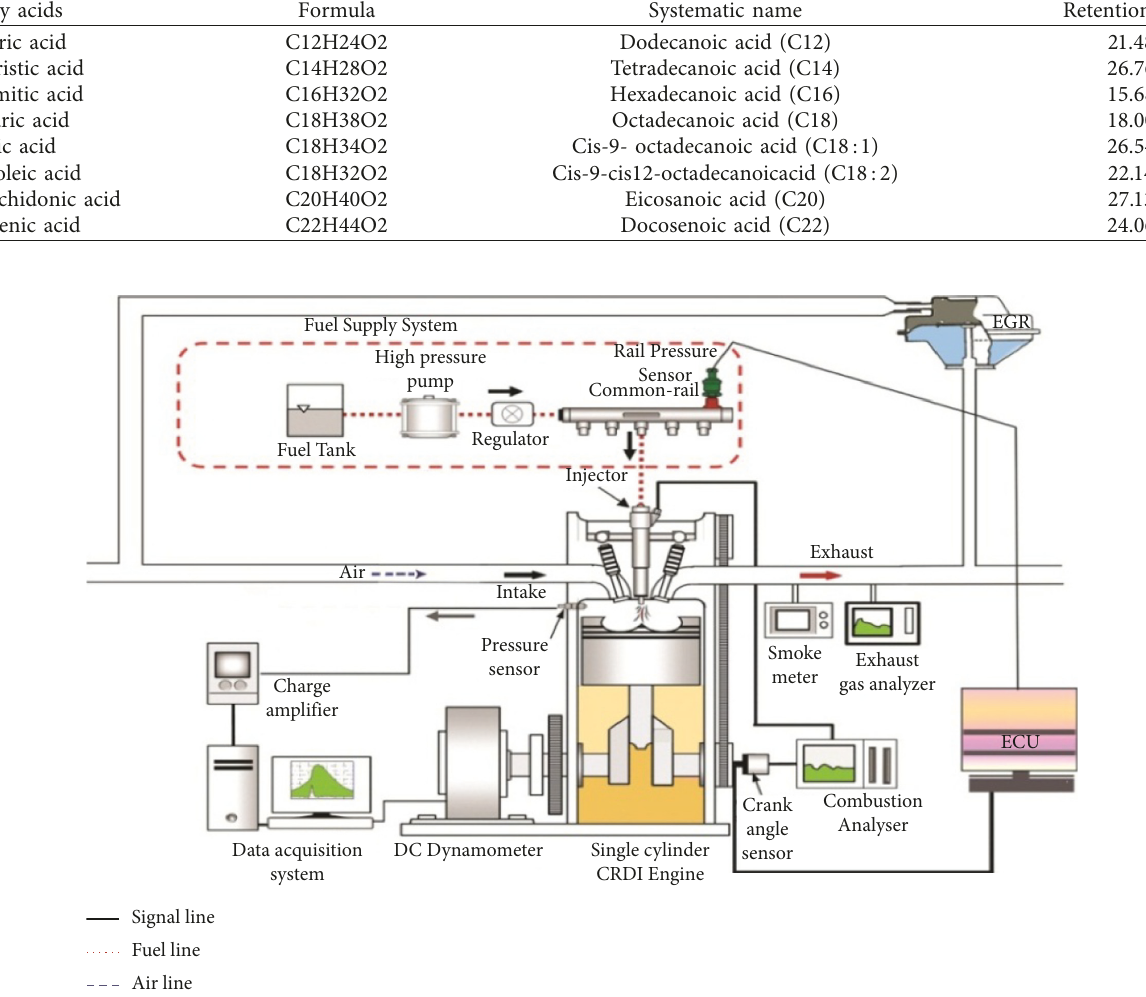
Figure 4: Layout of the experimental